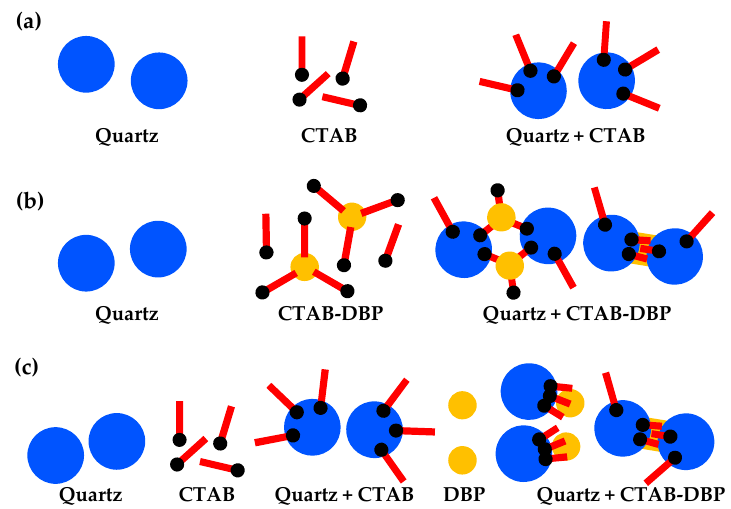
Figure 6. Schematic representation of interactions between quartz and CTAB ( a ), CTAB-DBP ( b ), CTAB and DBP ( c ).